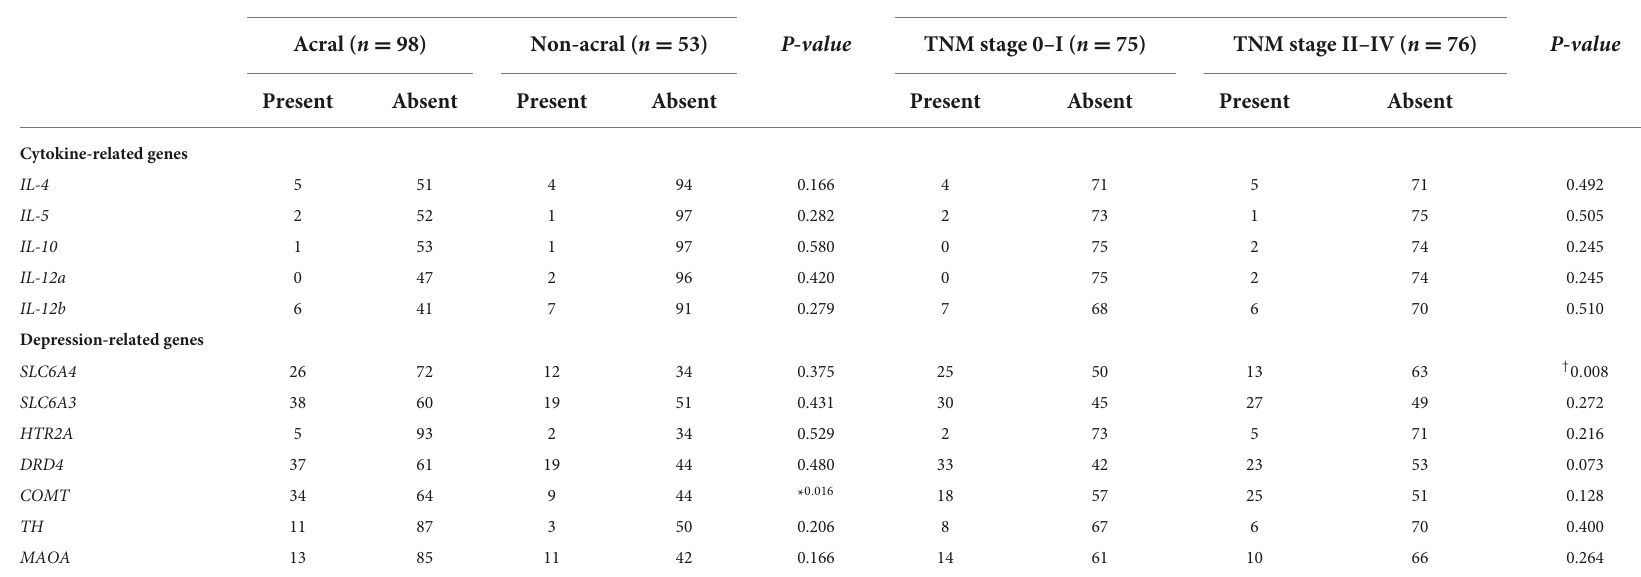
TABLE 4 Associations of cytokine- and depression-related gene mutations with anatomic sites and TNM stage of melanoma. Gene